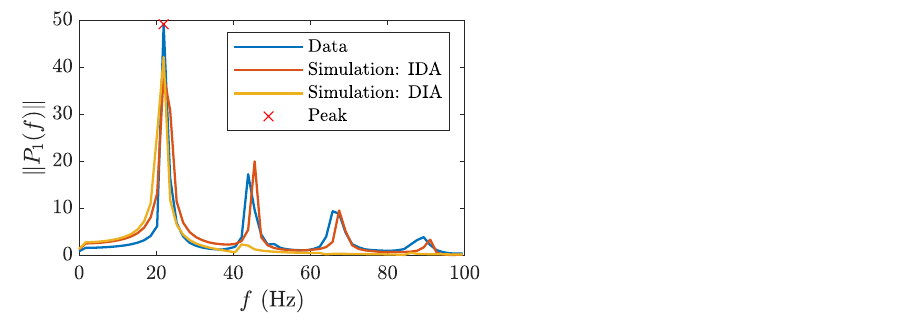
Figure 11. Power spectra of the measured signal (blue) and simulated signals in models obtained via IDA (red) and DIA